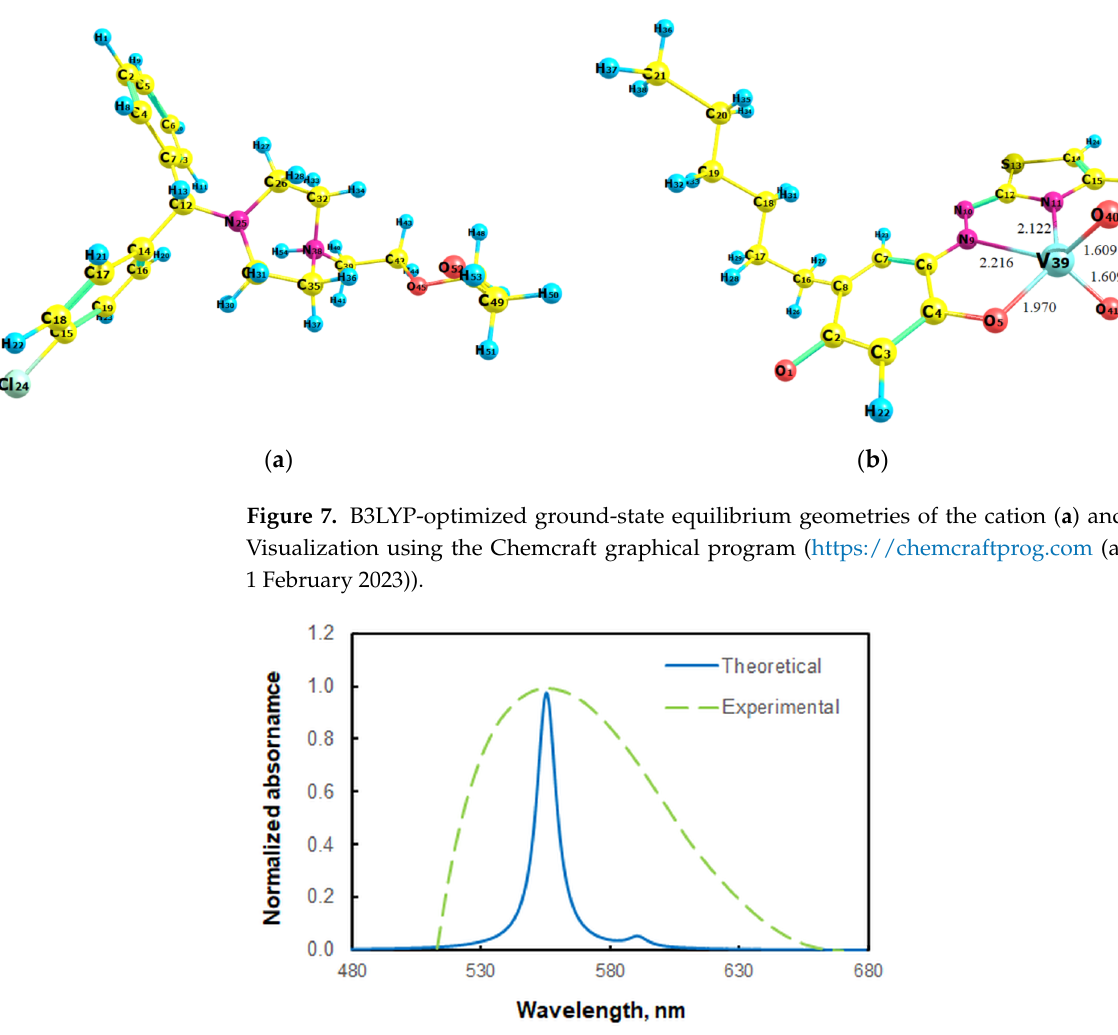
Figure 8. Comparison of the experimental spectrum of the extracted complex with a simulated spectrum (B3LYP/6-311++G** level of theory) of its anion moiety. A Lorentzian broadening and a scaling coefficient of 1.17 were used for the theoretical spectrum. Table 2. Vertical excitation energies and oscillator strengths of excited states of the anionic chelate calculated at the B3LYP/6-311++G** level of